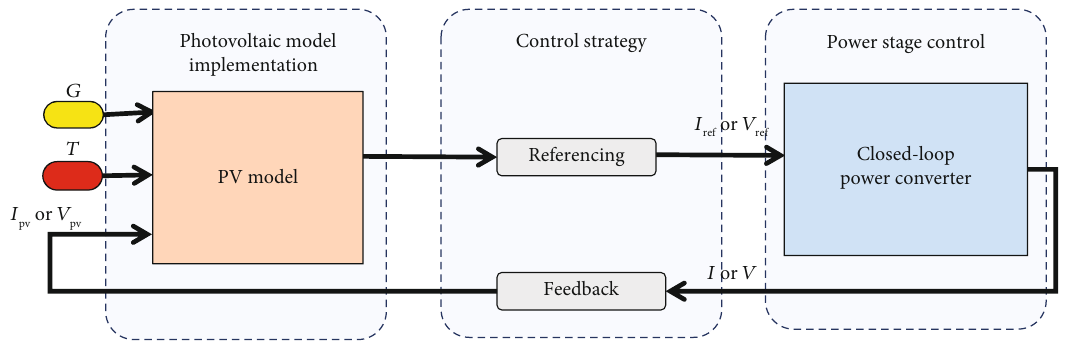
Figure 1: General photovoltaic emulator